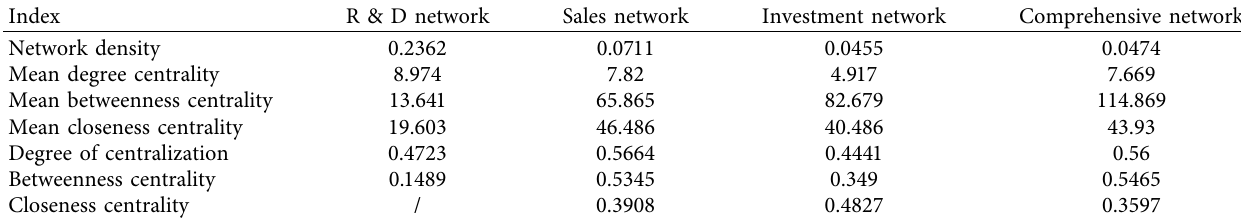
Table 1: Overview of network